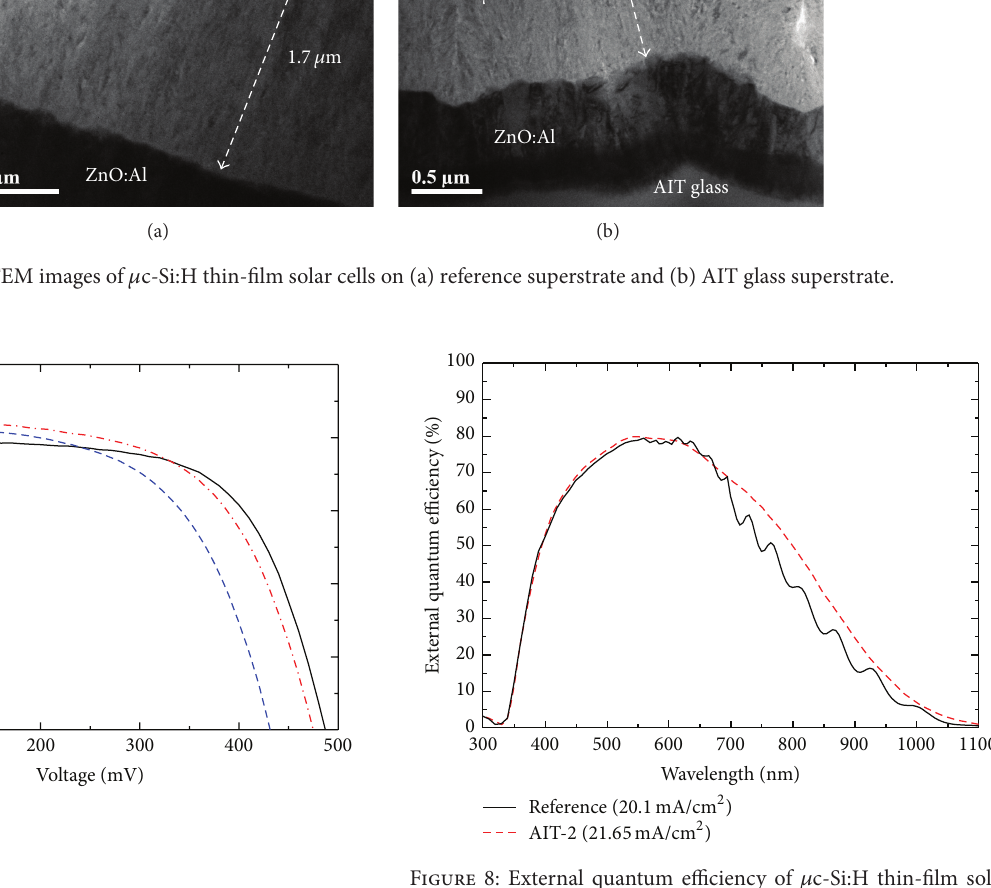
Figure 7: Measured one-sun 𝐼 - 𝑉 curves of 𝜇 c-Si:H solar cells processed on the three investigated superstrates.